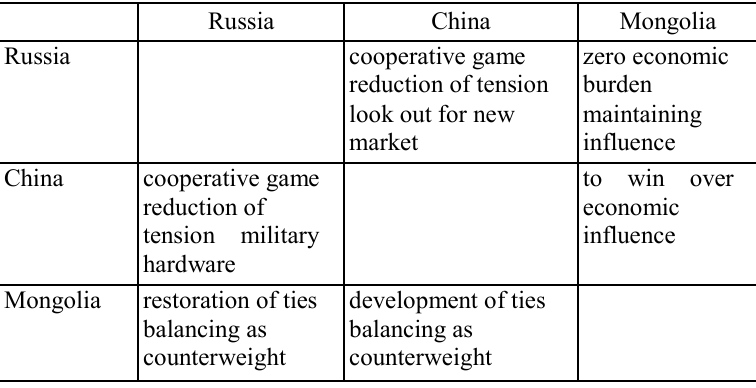
Table of Character of the game and interests of the